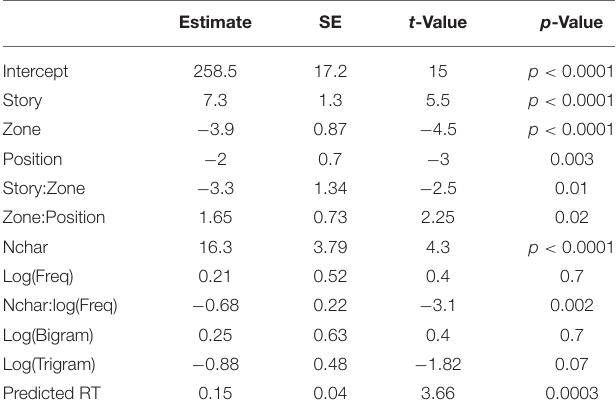
TABLE 4 | A full linear model for RTs in the